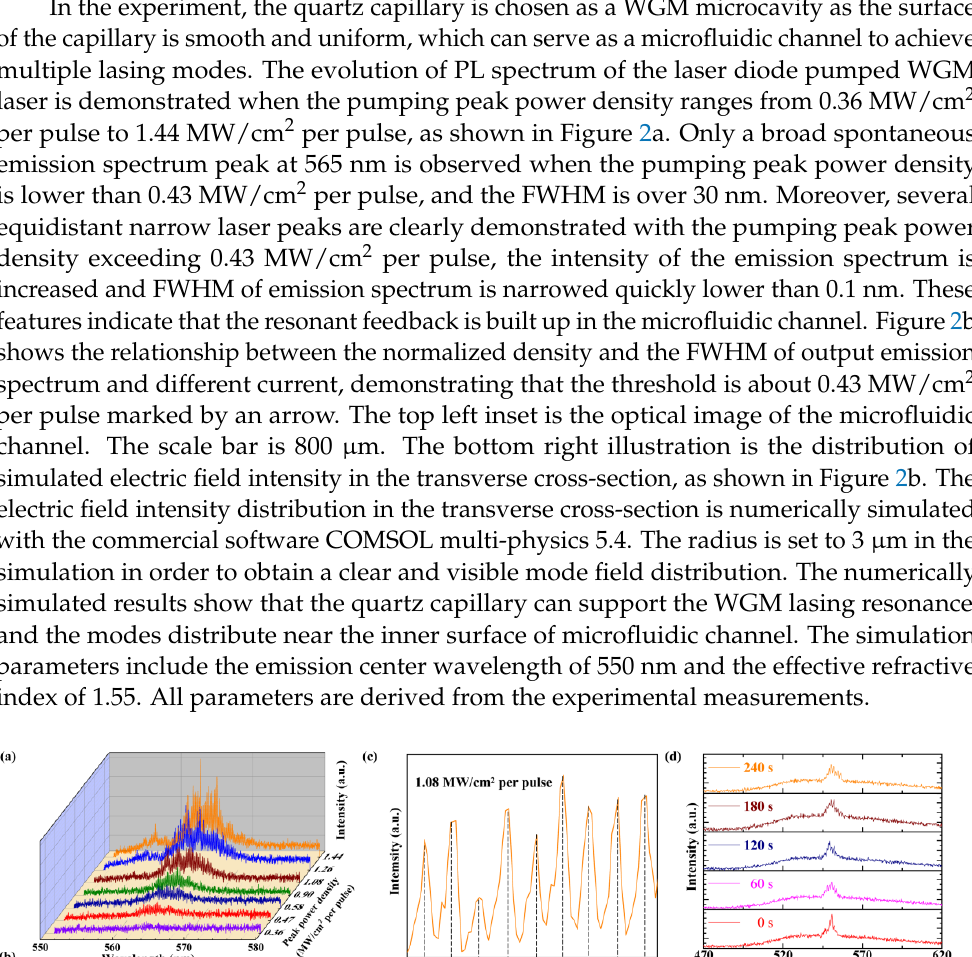
index of 1.55. All parameters are derived from the experimental measurements.